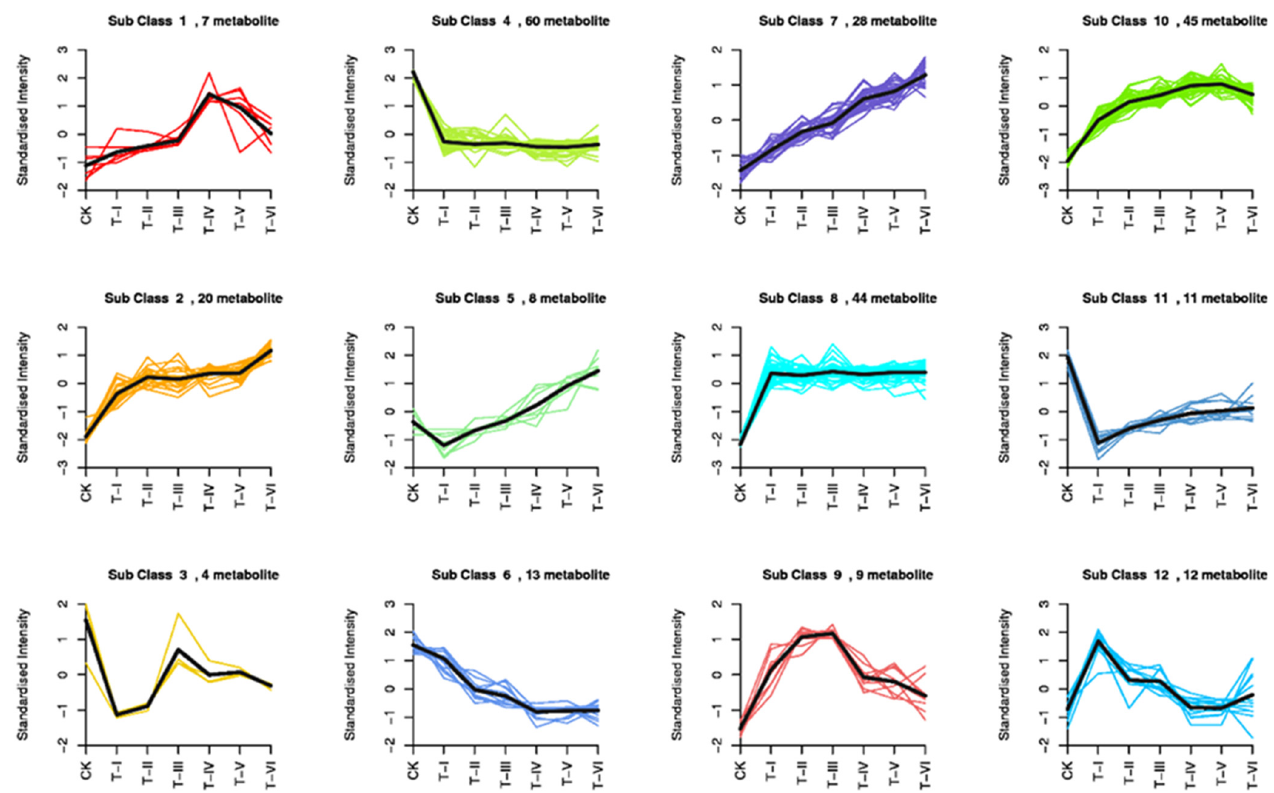
Figure 8. Results of k-means clustering analysis for different treatment groups. Treatment codes indicate the samples fermented for 0 d (CK), 5 d (T-I), 10 d (T-II), 15 d (T-III), 20 d (T-IV), 25 d (T-V), and 30 d (T-VI).